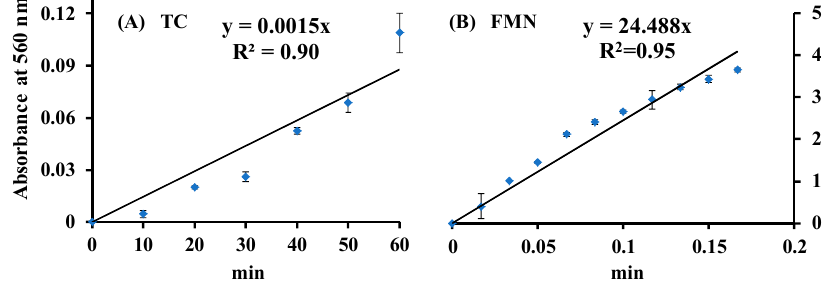
Figure 4. Effects of ( A ) TC and ( B ) FMN on nitro blue tetrazolium (NBT) reduction under blue light irradiation at 20 W/m 2 . The symbols ( ♦ ) in blue are the averaged absorbance of experimental data at different time points.